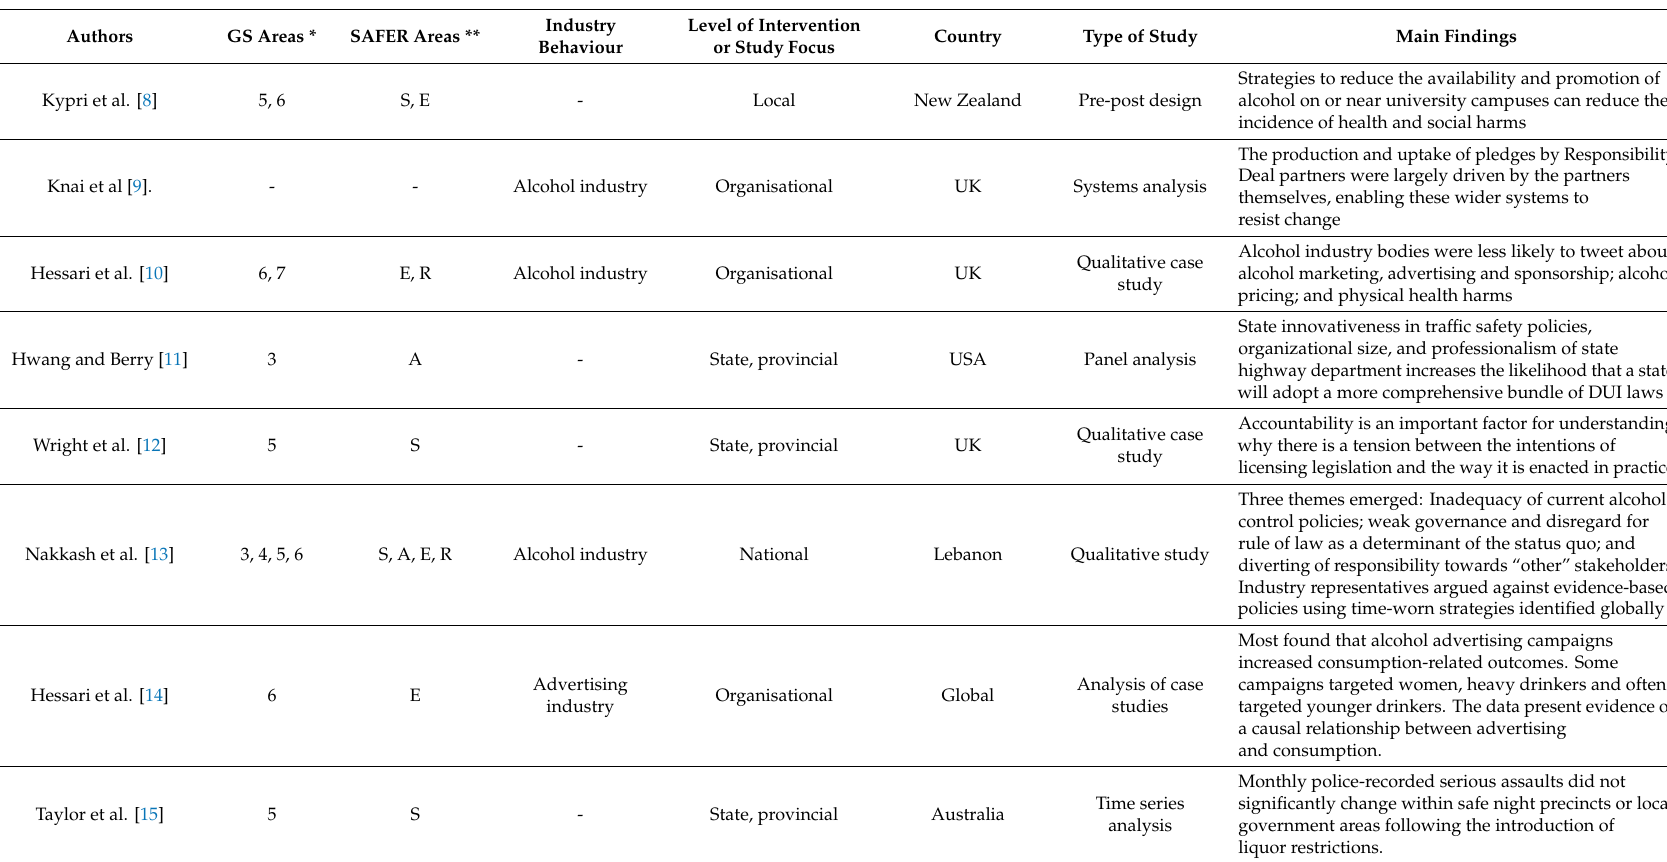
Table 1. Description of the areas covered by the research in the 15 articles in the special issue, the country of the study, the level of the intervention, the type of study and main